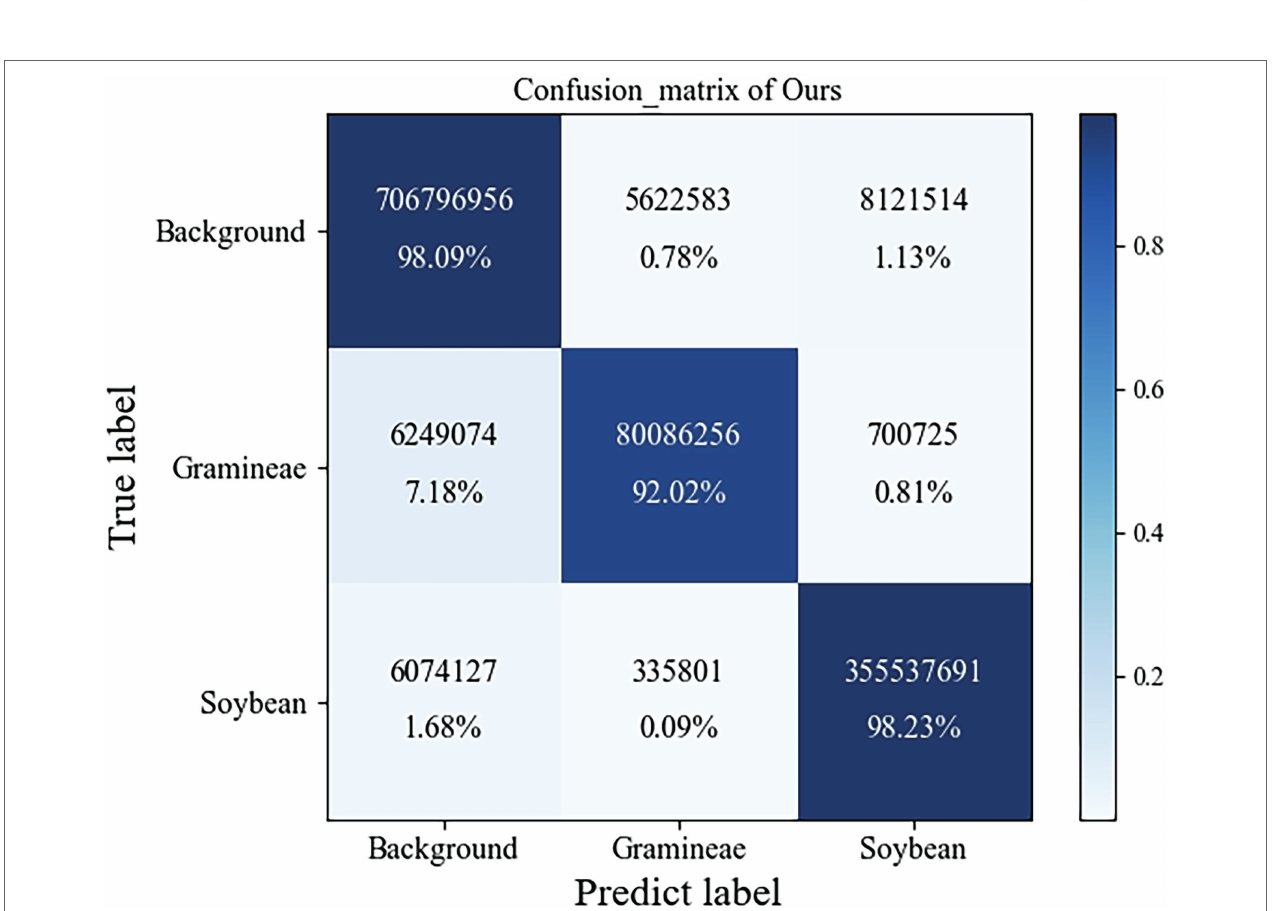
FIGURE 11 | The confusion matrix of our